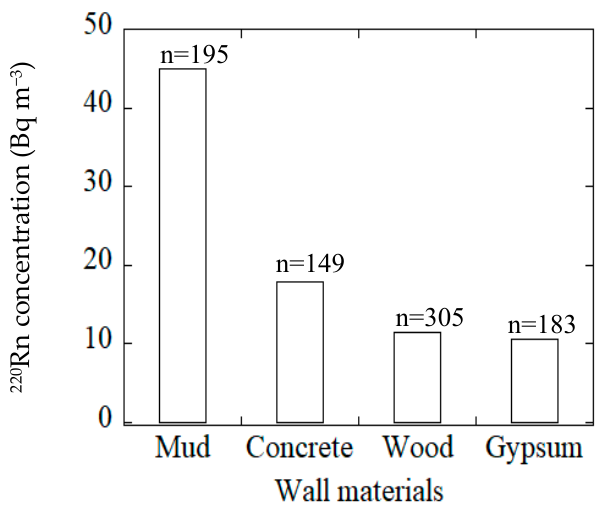
Figure 3. 220 Rn concentrations for various wall materials.